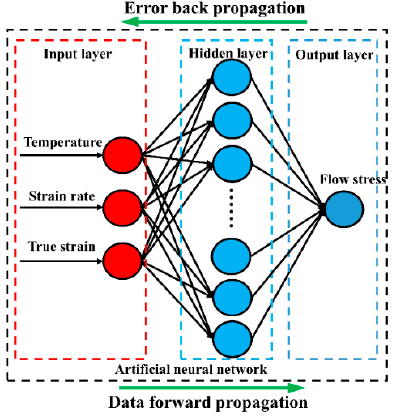
Figure 11. Schematic diagram of a typical three ‐ layer BP artificial neural network.